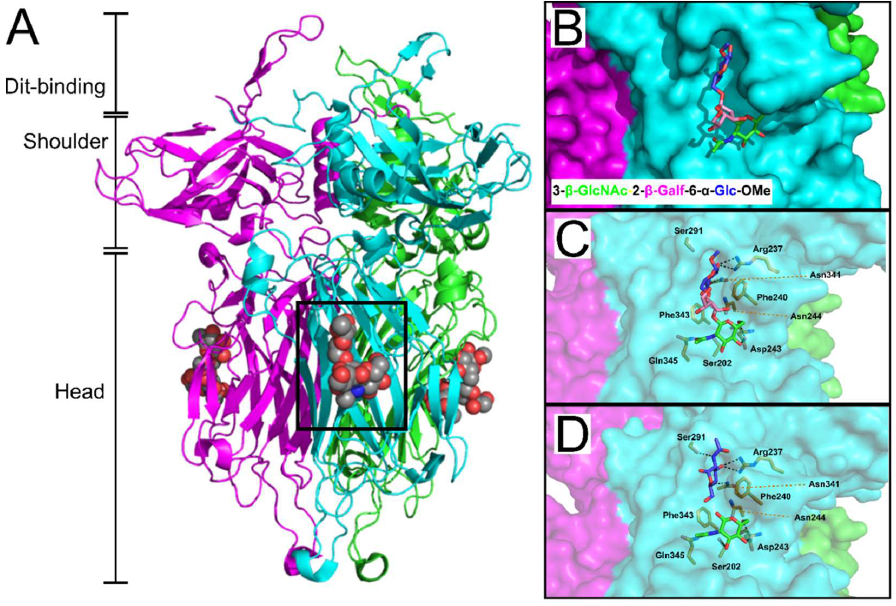
Figure 8. The pellicle core trisaccharide binding site of L. lactis phage 1358. ( A ) Cartoon representation of the L. lactis phage 1358 RBP (ORF20) (PDB ID: 4RGA) [122] with the synthesized trisaccharide (resembling the native core structure) shown as spheres (carbon = grey, nitrogen = blue, oxygen = red) bound within the same cleft on the side of the head domain of each monomer (colored cyan, green, and magenta). Highlighted are the receptor-binding head domain, central shoulder domain, and the N-terminal Dit-(interaction) domain; the function of the latter domain is to attach the RBP to the central Dit hexamer ring of the baseplate. ( B ) Surface representation of the saccharide binding cleft of the 1358 RBP, with the core trisaccharide shown as sticks. ( C ) The interaction between the trisaccharide to the 1358 RBP binding cleft involves hydrogen/ionic bonding (yellow dashed lines) with various cleft-forming residues. ( D ) Individual GlcNAc residues (blue and green; PDB ID: 4L92) [73] interact with equivalent hydrogen/ionic bonds as their respective single saccharides of the synthetic